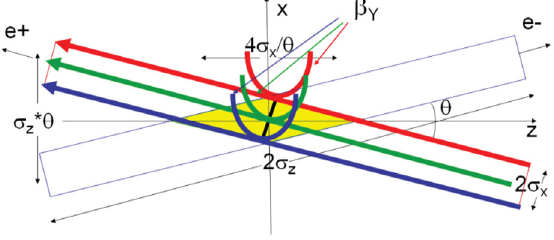
FIG. 1. Collision with a large Piwinski